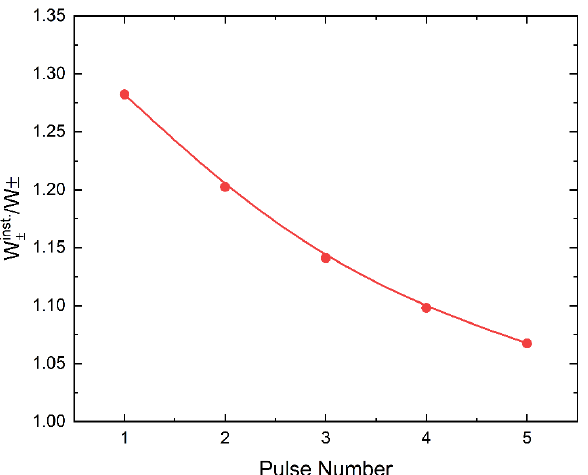
Figure 4. The ratios of W ± measured immediately after the application of the bias ( W ±inst. ) to W ± measured after waiting 10 min post bias application ( W ±inst. /W ± ). Note that W ± , measured 10 min amount of waiting, the ehp creation energy remains relatively constant, undergoing very little change over